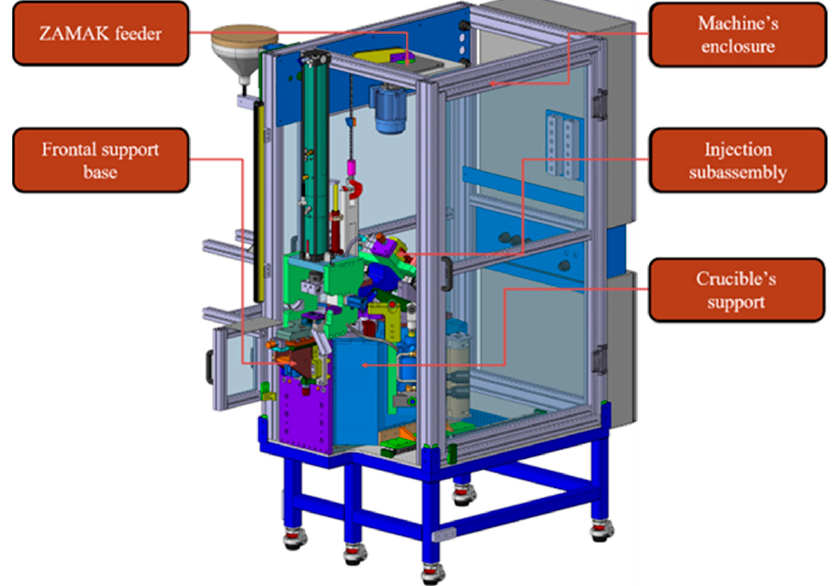
Figure 8. Injection machine and its main components.